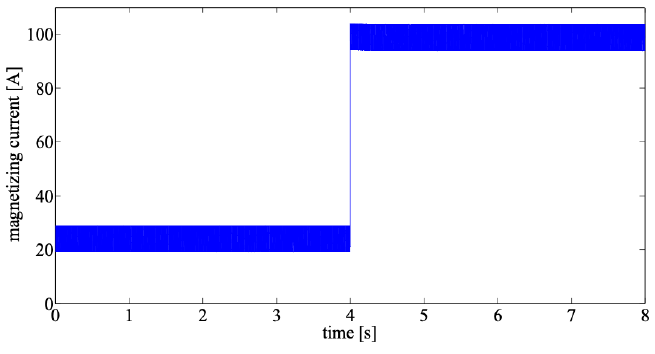
Figure 11. Magnetizing current (case A).